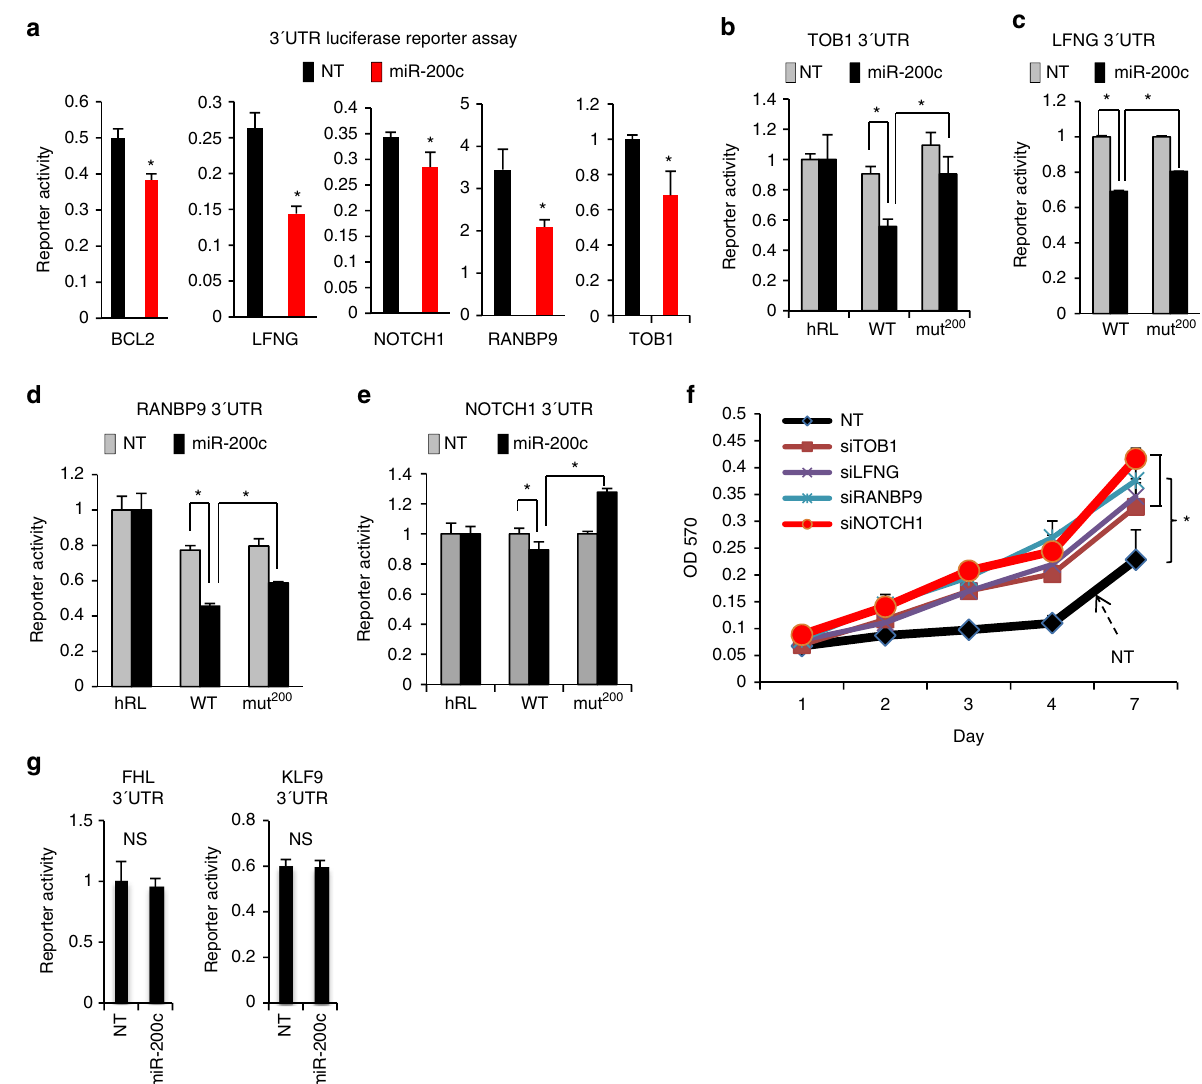
Figure 5 | The validation of ERBB3-regulating genes as miR-200c targets. ( a ) 3 0 -UTR reporter assays for H1299 cells transiently co-transfected with miR-200c and the indicated genes’ 3 0 -UTR reporter plasmids. (triplicates; mean plus s.d.). * indicates t -test P o 0.05. Mutation of the miR-200c-binding site abrogates the inhibitory of miR-200c on the activity of 3 0 -UTRs of TOB1 ( b ), LFNG ( c ), RANBP9 ( d ) and NOTCH1 ( e ). (triplicates; mean plus s.d.). *indicates t -test P o 0.05. ( f ) MTTassay for HCC827-ZEB1 cells transiently transfected with siRNAs against NOTCH1, TOB1, LFNG, RANBP9 or a control non-targeting siRNA (N.T.). (triplicates; mean plus s.d.). * indicates t -test P o 0.05. ( g ) 3 0 -UTR reporter assays for H1299 cells transiently co-transfected with miR-200c and the indicated genes’ 3 0 -UTR reporter plasmids. N.S., not statistically significant ( t -test P 4